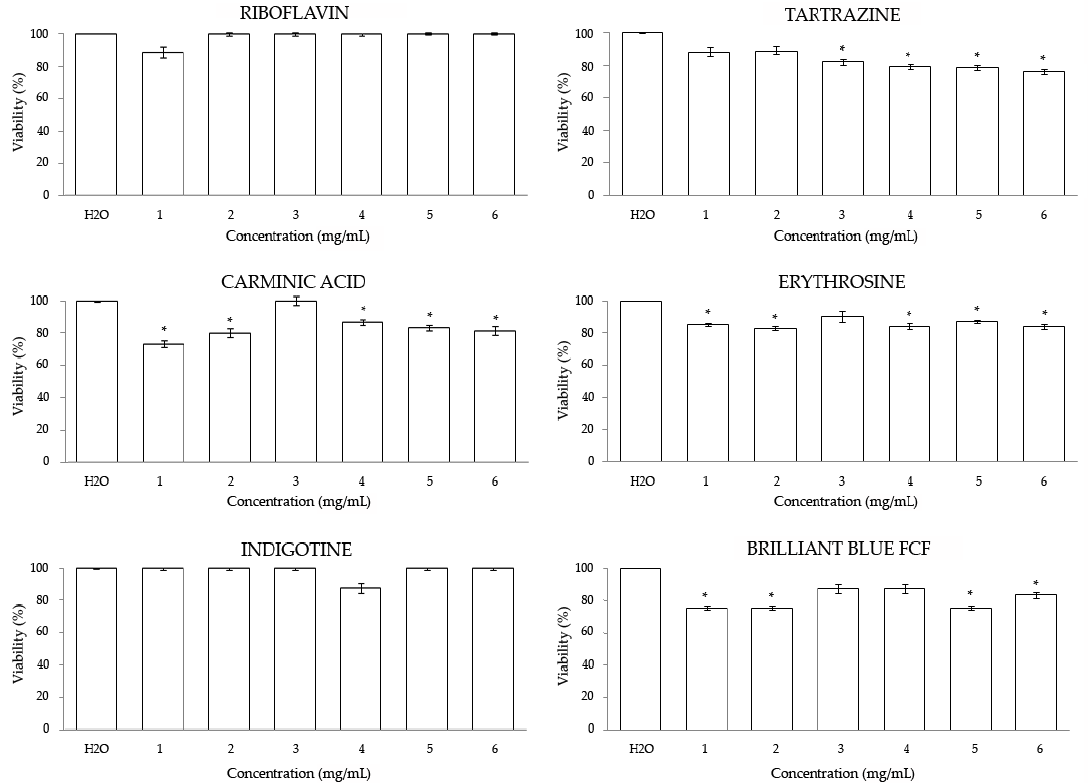
Figure 1. Toxicity levels of food coloring in Drosophila melanogaster . Data are expressed as percentage of surviving adults with respect to 300 untreated 72 h-old larvae from three independent experiments treated with different concentrations of food colorings. Values represent the mean ± SE from three independent experiments. * Indicates significant differences with respect to the control. 1– 6 numbers indicate the different dilutions tested (see Table 1).